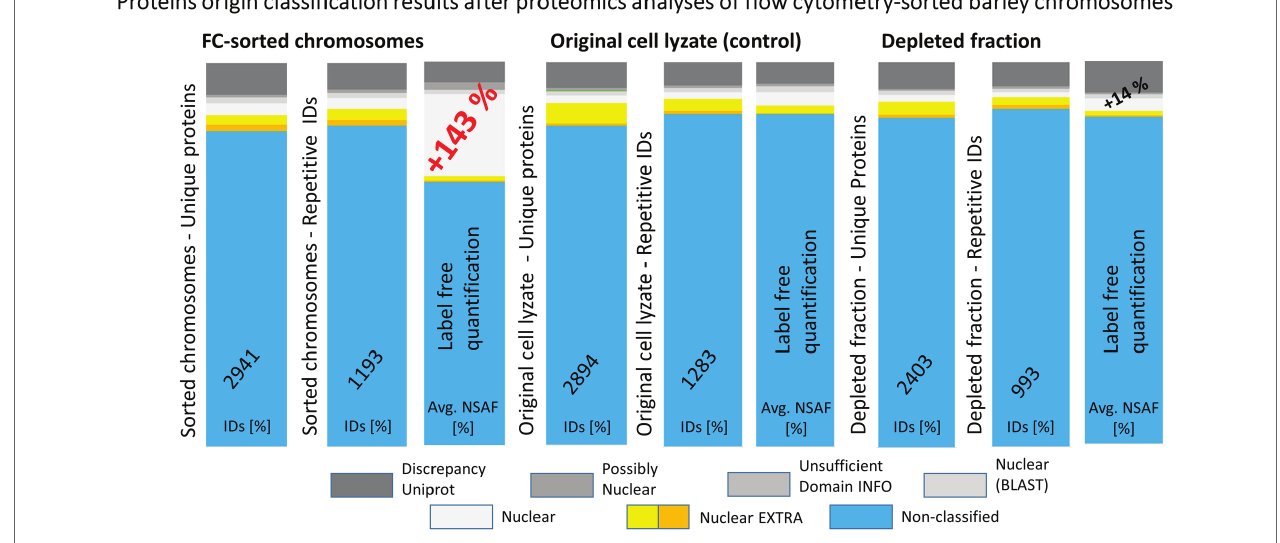
FIGURE 4 | A summary of results obtained from repeated experiments with different starting biological materials. The bar plots show a comparison of protein identification results obtained using MG separation of peptides from tryptic digests followed by nLC-ESI-Q-TOF MS/MS. Three types of biological material were used for the proteomics analyses: flow cytometry-sorted barley chromosomes, original plant cell lyzates (as a control), and depleted fractions after the flow cytometry. Repetitive IDs refer to repeated experiments, where the counted hits were obtained for at least two biological replicates (three biological replicates were analyzed in total, each was run in two technical replicates). The graphics depict percentages of the protein ID categories attributed in S2 search and the corresponding NSAF values.